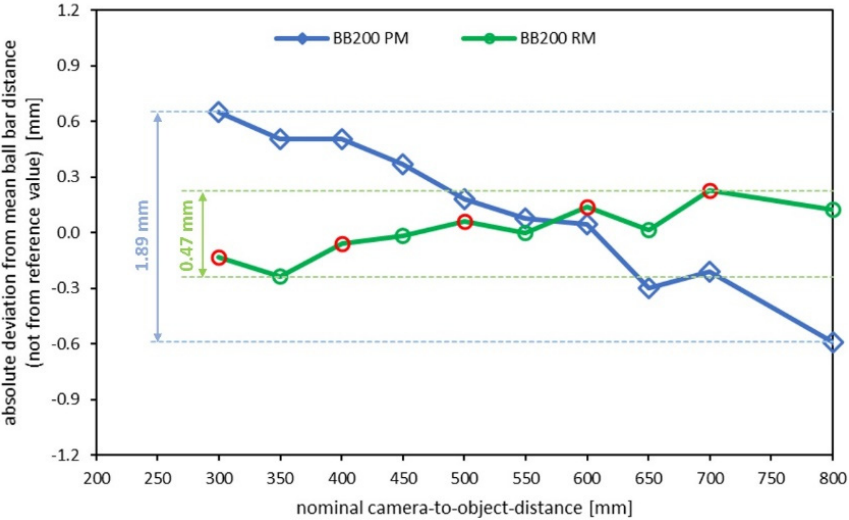
Figure 11. Length measurement results. RM = ray-based calibration (green curve), PM = pinhole calibration (blue curve). Red circles mark the values used for refinement.